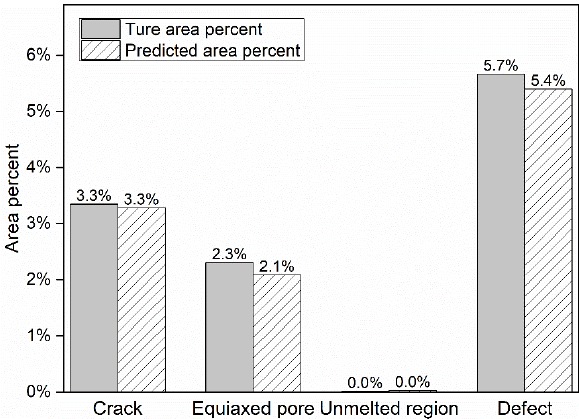
Figure 14. True and predicted area percentages for each class of microstructure in a hypothetical image containing all the 39 typical APS TBC images.